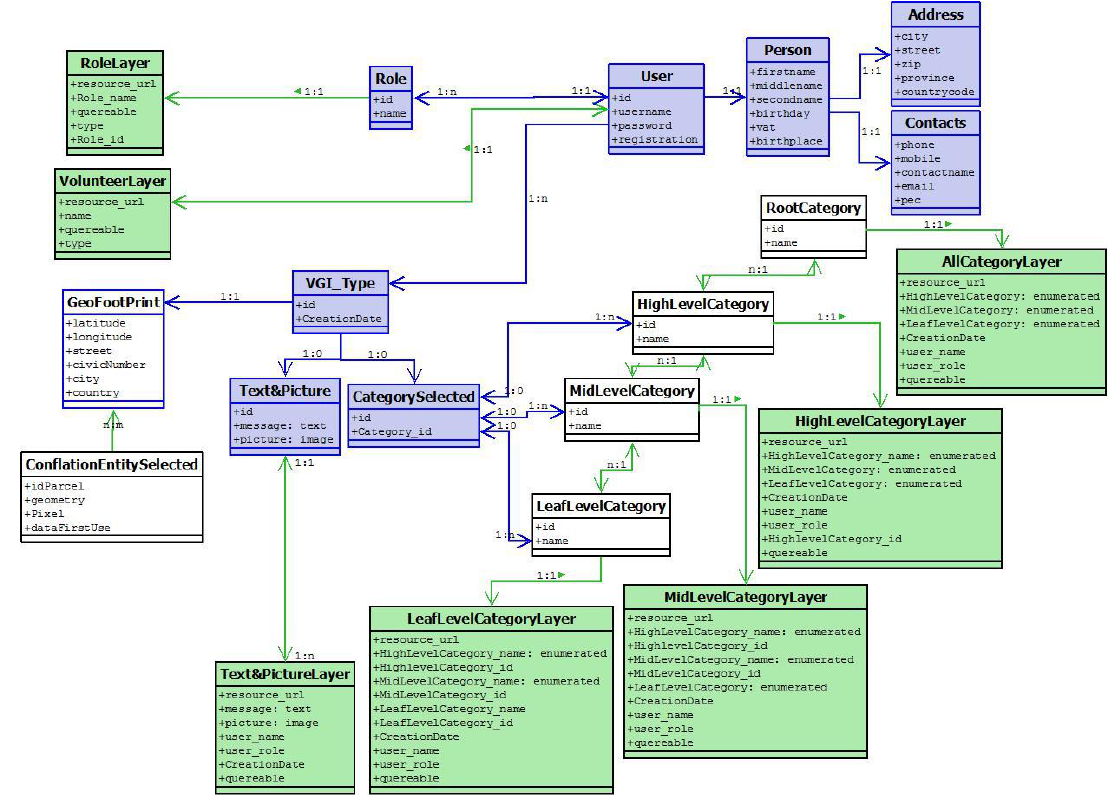
Figure 3. Schema of the GD base containing the in-situ observations.